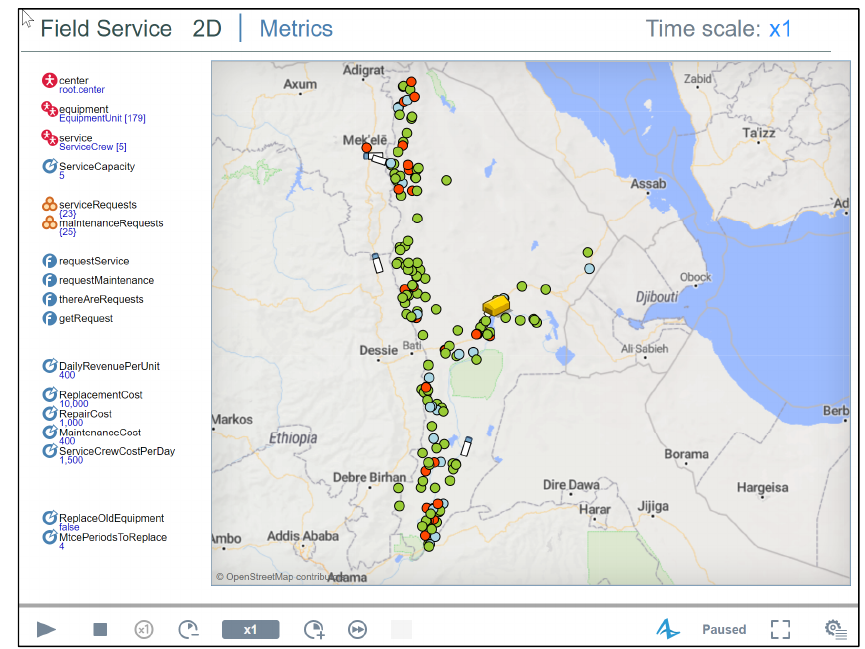
Figure 5. 2D model part of the AB flight simulator in AnyLogic showing the fixed service center and the status of the equipment at the 179 borehole sites using the color code of Figure 3. Challenges 2019, 10, x